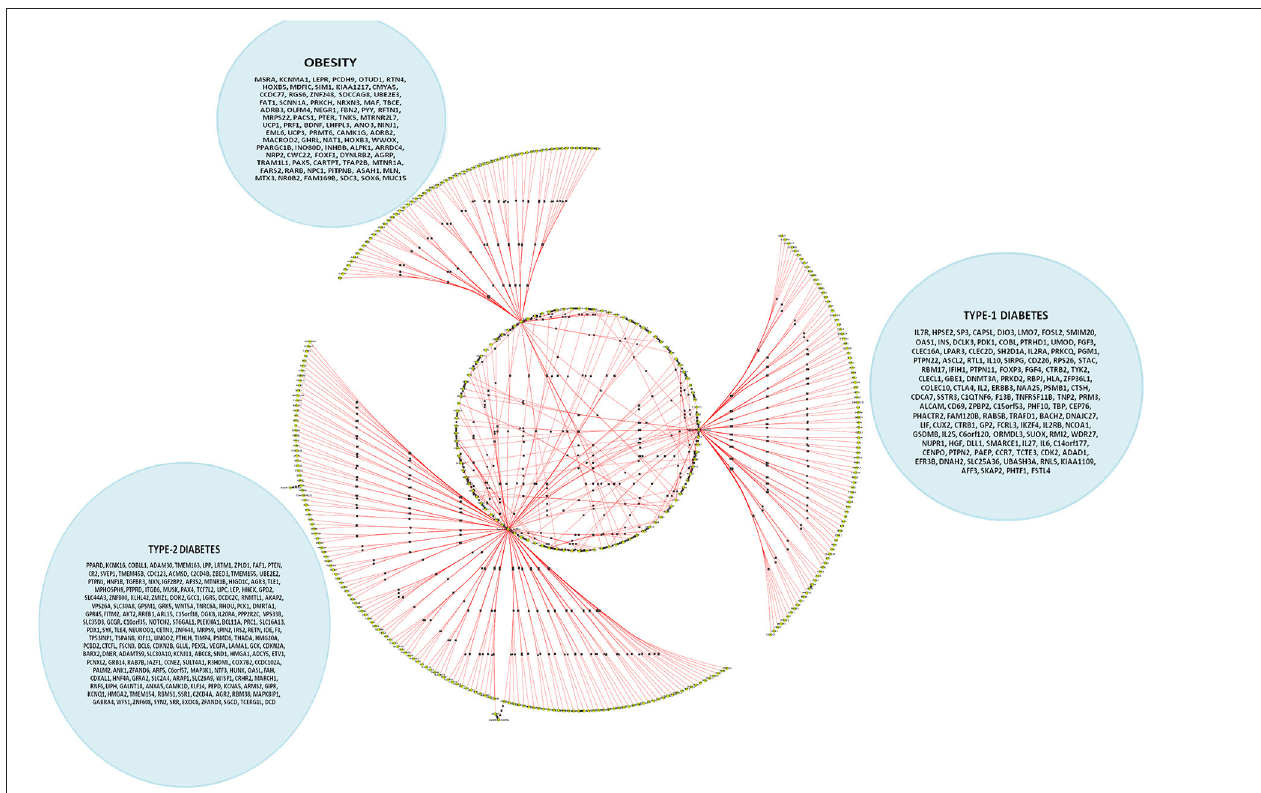
FIGURE 5 | A cohort of genes bundled across three contexts, viz. type 1 diabetes mellitus (T1D), type 2 diabetes mellitus (T2D) and obesity (see Supplementary Table 3c